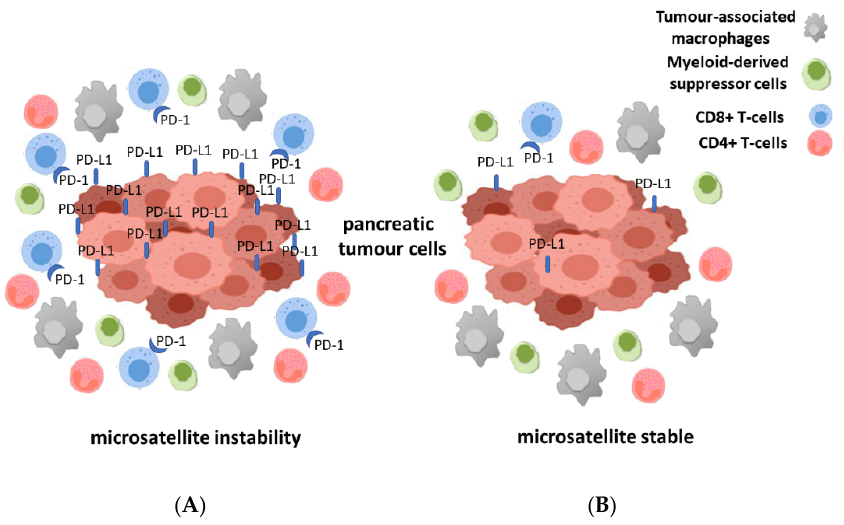
Figure 1. Illustration of the different immune milieu for microsatellite instable (MSI) ( A ) and microsatellite stabile (MSS) ( B ) pancreatic cancer. The different number of immune cells espe- cially of CD8 + and CD4 + T-cells, myeloid-derived suppressor cells (MDSCs) and tumor-associated macrophages (TAMs) in the tumor microenvironment of the two groups of pancreatic cancer is shown.